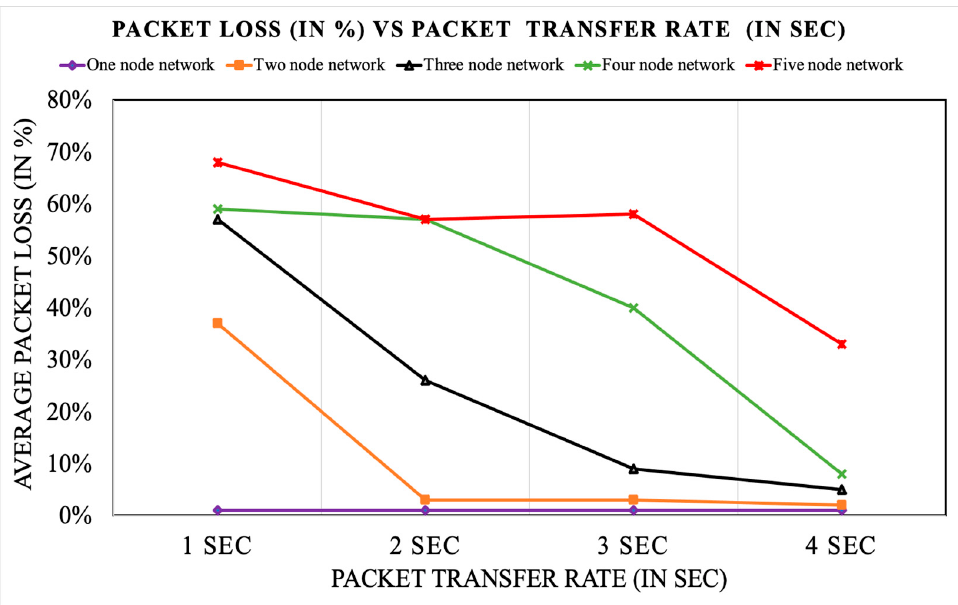
Figure 7 . Average packet loss analysis for a static five-node network at the gateway edge level. In- creasing the number of nodes significantly influences the size of packet loss when detailed data are